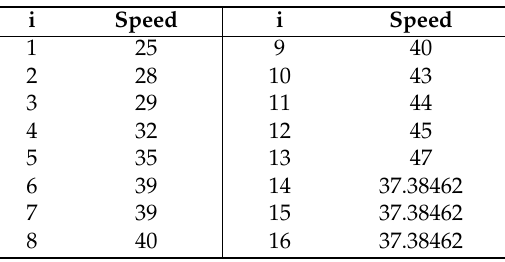
Table 4. Vehicles Speed after